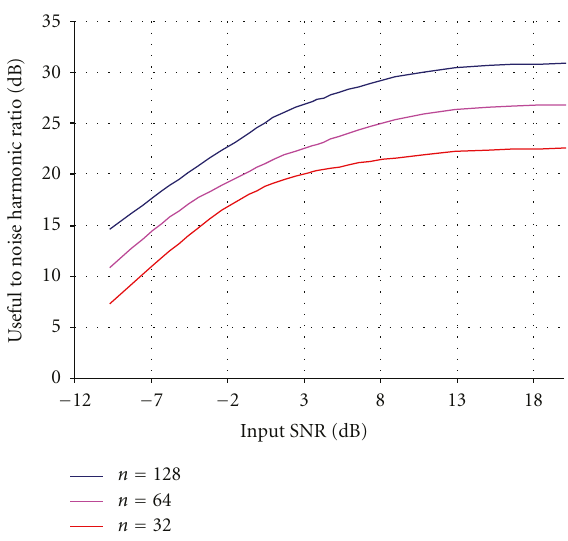
Figure 8: Detection threshold according to the input SNR.